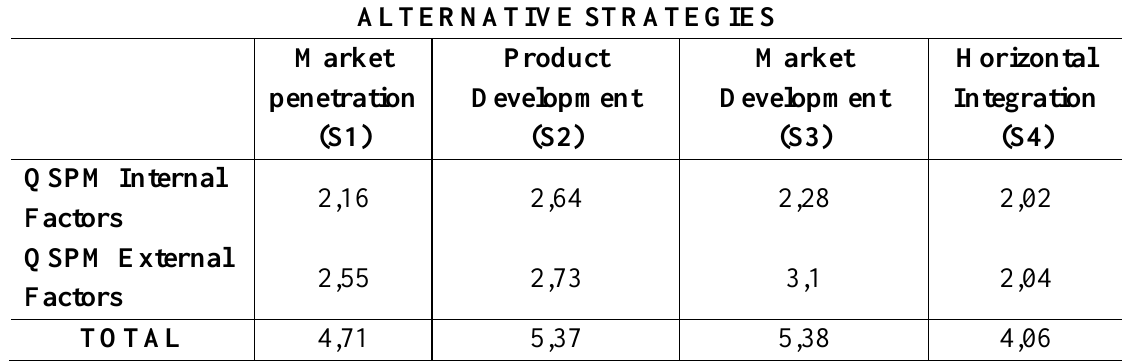
Table 7. QSPM Results for Total Internal and External